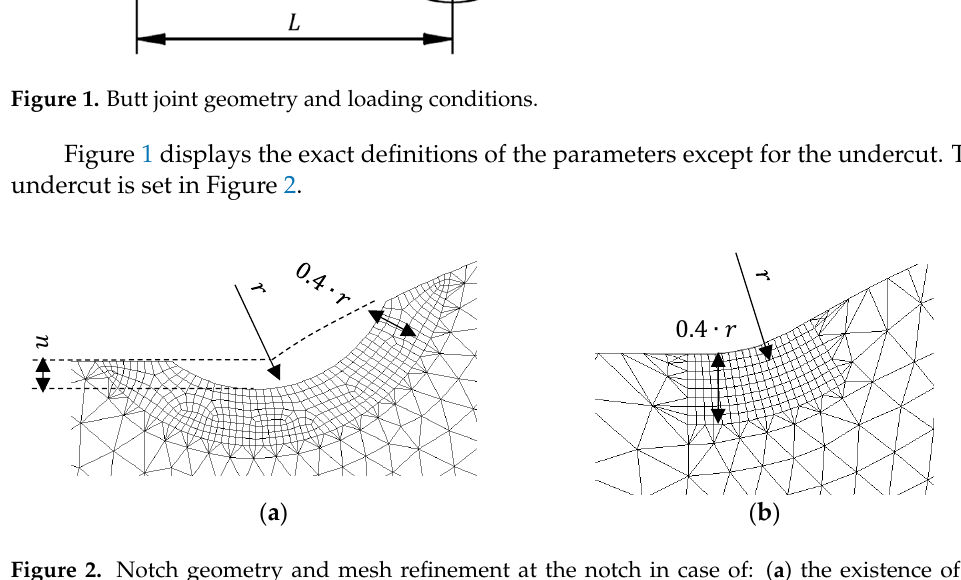
Figure 2. Notch geometry and mesh refinement at the notch in case of: ( a ) the existence of an undercut; ( b ) the absence of an undercut.